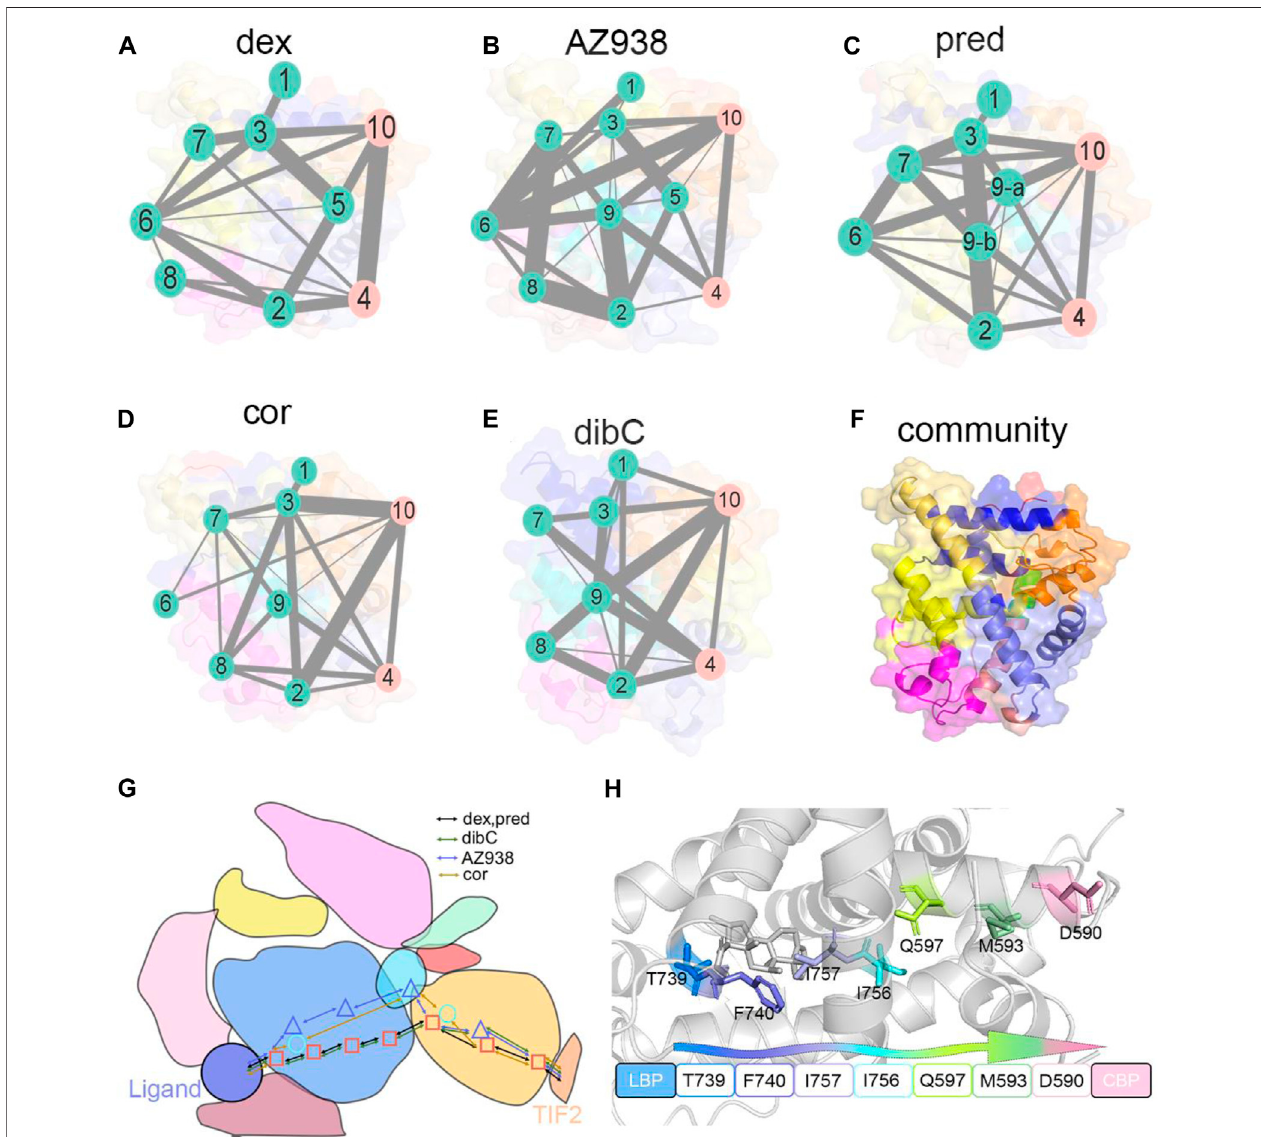
FIGURE 9 | Community networks and the allosteric signaling pathways in each simulation system. Community network representation of (A) dex-bound system, (B) AZ938-bound system, (C) pred-bound system, (D) cor-bound system, and (E) dibC-bound system. (F) cartoon representation of cluster distribution in GR. Each sphere represents an individual community, and the thickness of sticks connecting communities is proportional to the corresponding edge connectivity. Schematic representation (G) of the domain-level allosteric signaling pathway and cartoon representation of signal propagations (H) connecting D590 and T739 in fi ve